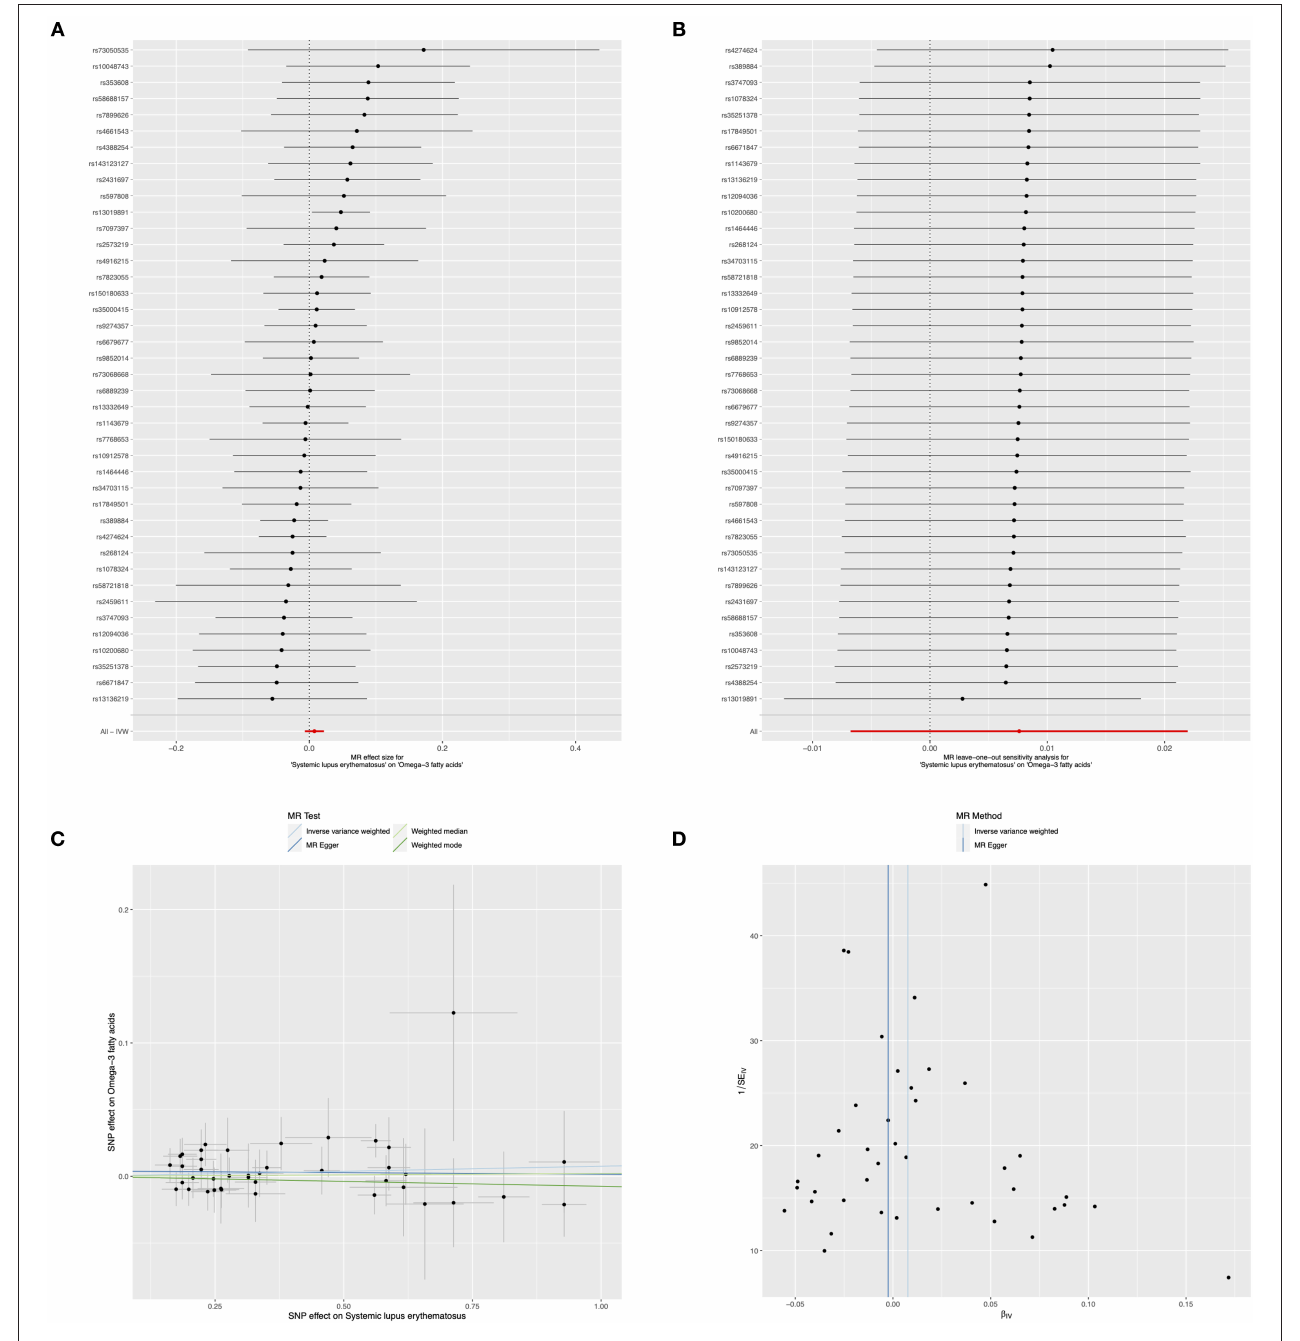
FIGURE 4 | Mendelian randomization study of the effects of SLE on omega-3 levels. Forest plot (A) , leave-one-out sensitivity analysis (B) , scatter plot (C) , and funnel plot (D) of the genetically risk of SLE on circulating omega-3 levels.